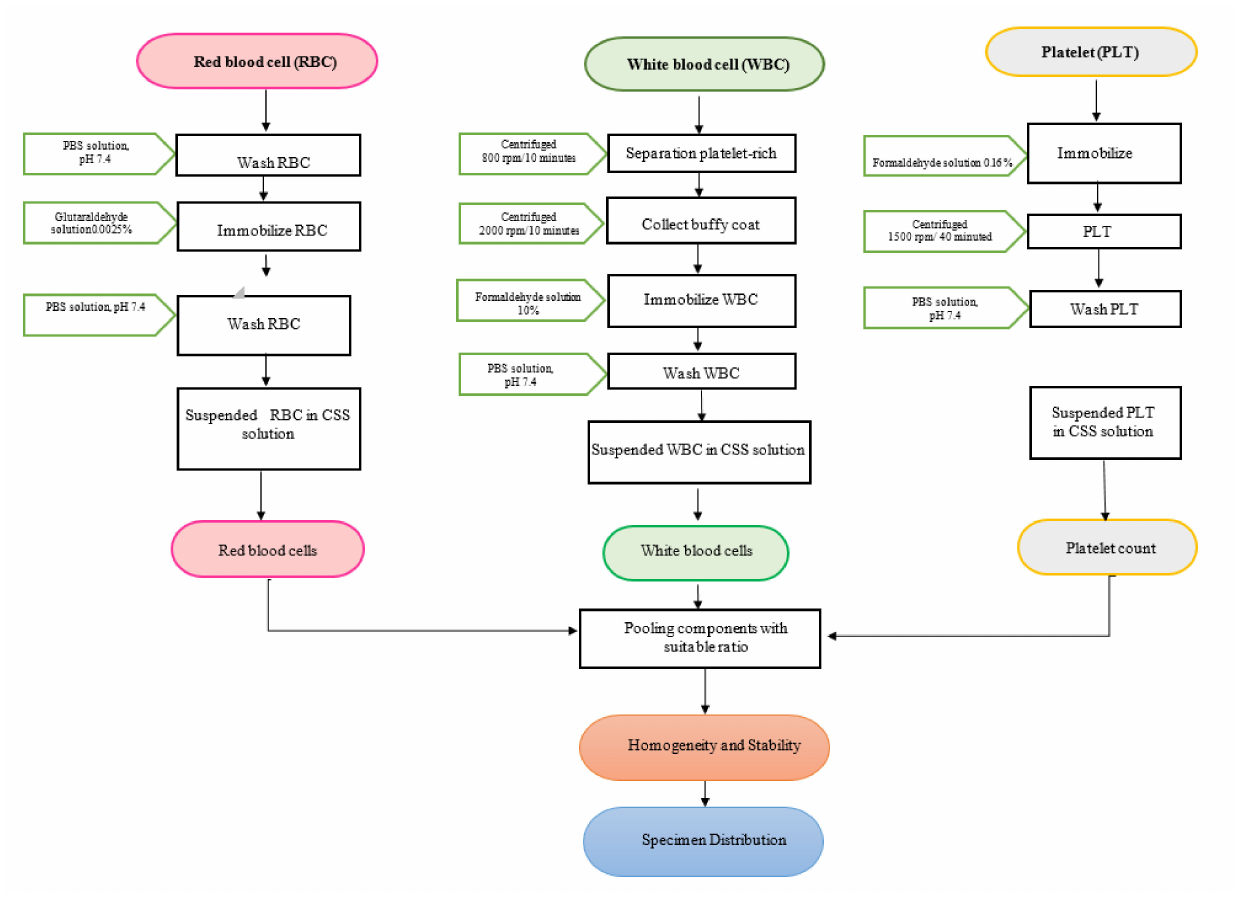
Figure 1. Flow chart of the research